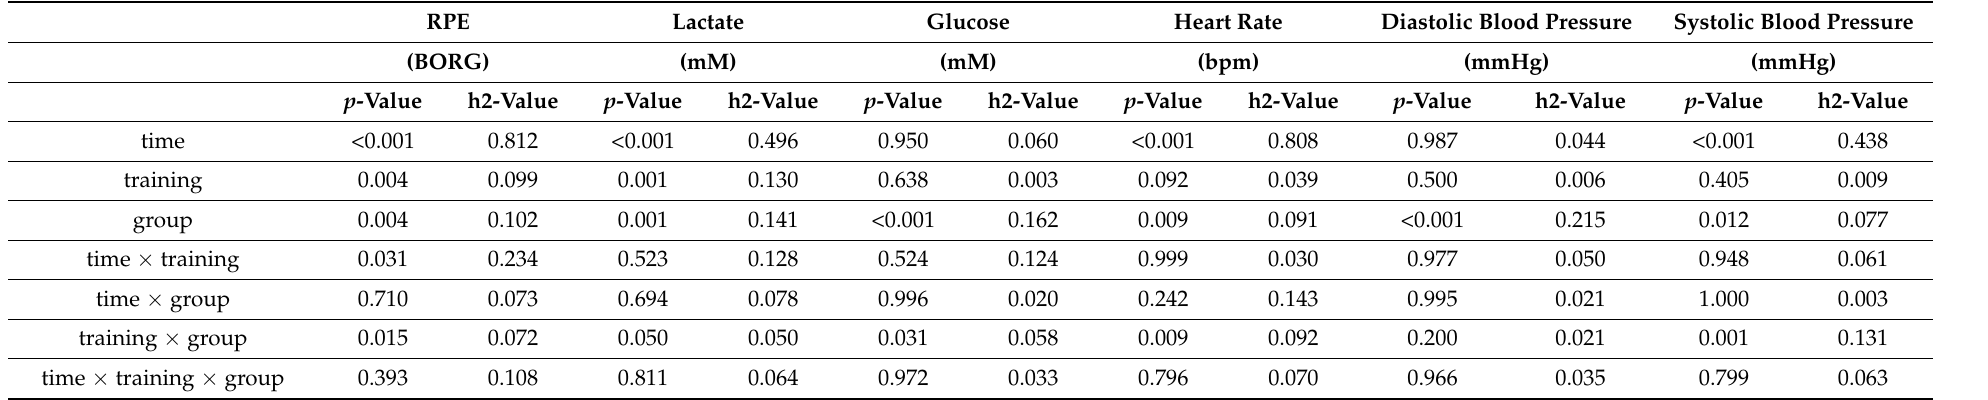
Table 4. Effects of training and contraction group on the response of cardiovascular and metabolic parameters to interval exercise. Test statistics ( p -values and effect sizes) for the single and interaction effect of interval ‘training’ × the contraction ‘group’ on the temporal alterations of cardiovascular parameters during interval exercise. ANOVA with test correction for Roy’s Largest Root. RPE, rate of perceived